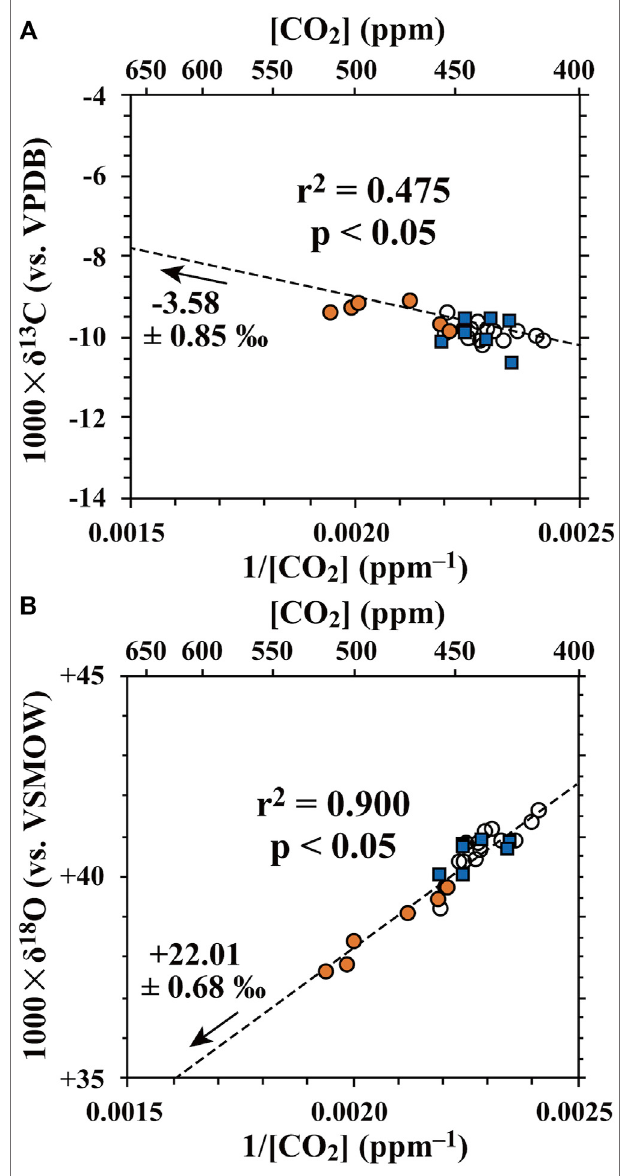
FIGURE 7 | (A) Relationships of carbon and (B) oxygen isotopic compositions of CO 2 with reciprocal CO 2 concentrations (1/[CO 2 ]) in the plume/air samples collected using SelPS (orange circles: plume samples derived from the main vent; blue squares: those derived from the southern fumaroles) and those collected manually into fl asks (white circles). The dotted lines represent the regression lines calculated for all the samples according to Cantrell,